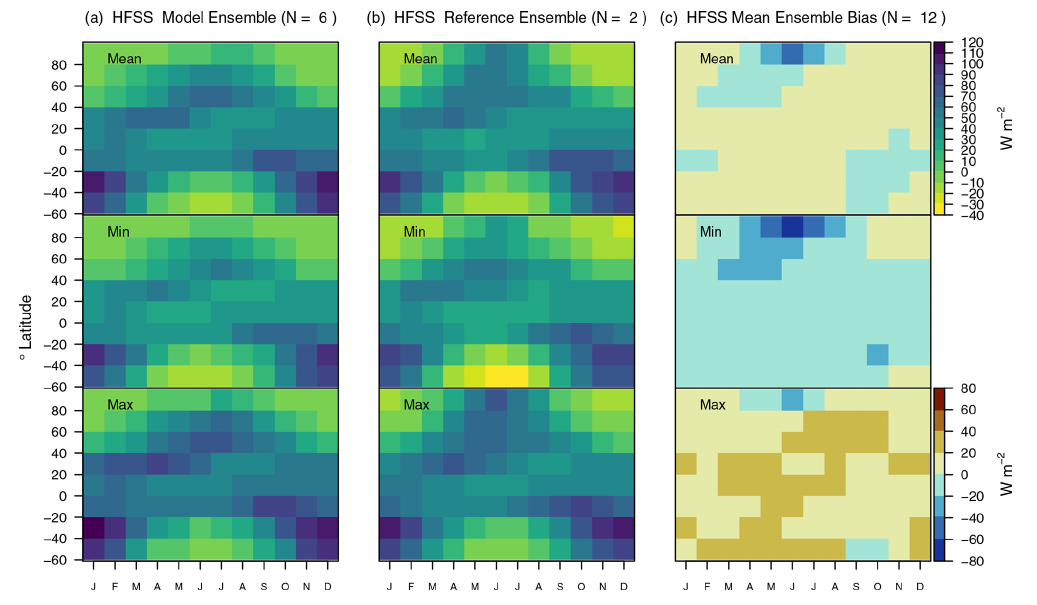
Figure A9. Same as in Fig. 8 but for sensible heat